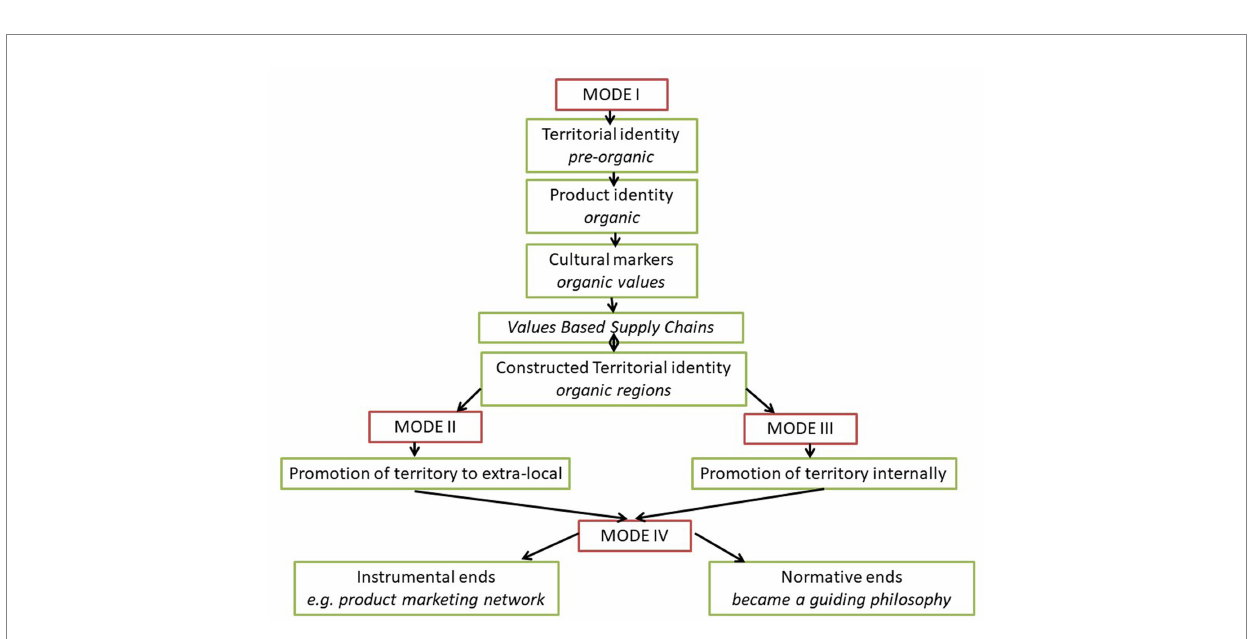
FIGURE 2 Adapted model of neo-endogenous development after Stotten et al.,